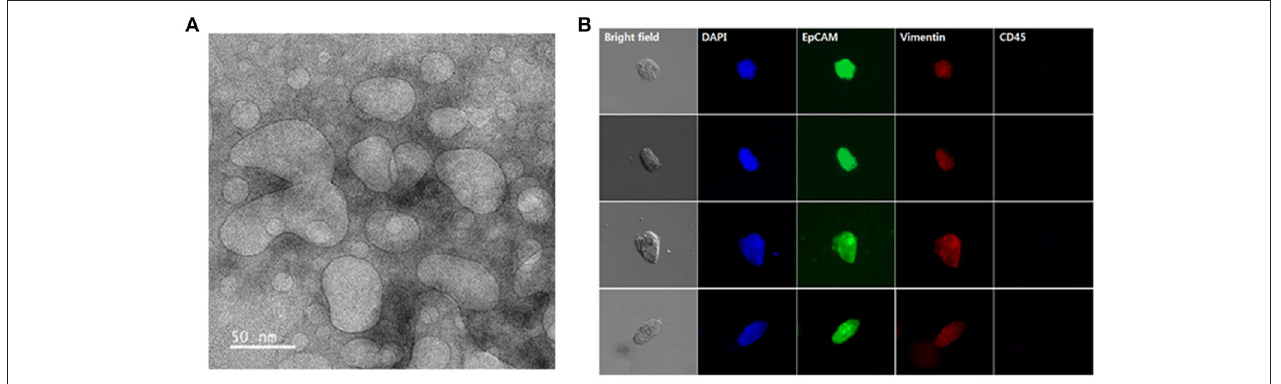
FIGURE 6 | Exosomes and circulating tumor cells (CTCs) were sequentially isolated from the plasma and whole blood of lung cancer patients using the same nanowire platform. (A) Transmission electron microscopy image displaying the presence of exosomes isolated from 1mL of plasma from lung cancer patients (scale bar, 50nm). (B) Representative immunocytochemistry images of CTCs captured from 1mL of whole blood from lung cancer patients. Cells were stained with DAPI (nucleus; blue), CD45 (hematopoietic; red), EpCAM (epithelial; green), and vimentin (mesenchymal;